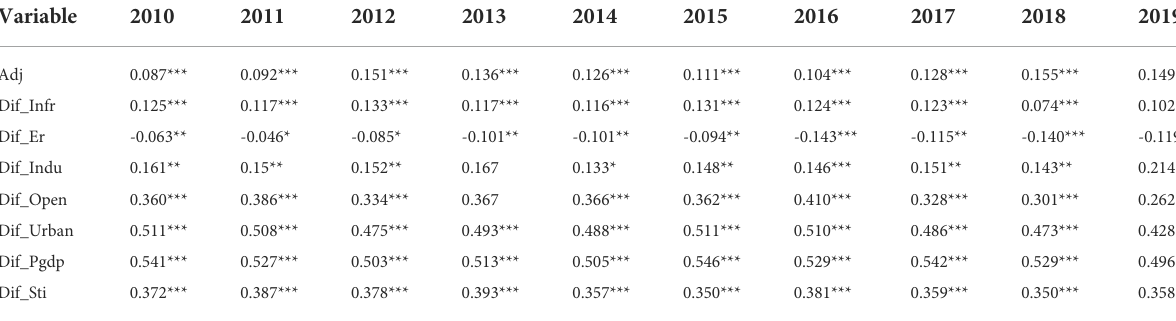
TABLE 8 QAP correlation analysis results of driving factors and regional GIE (2010 – 2019). Variable